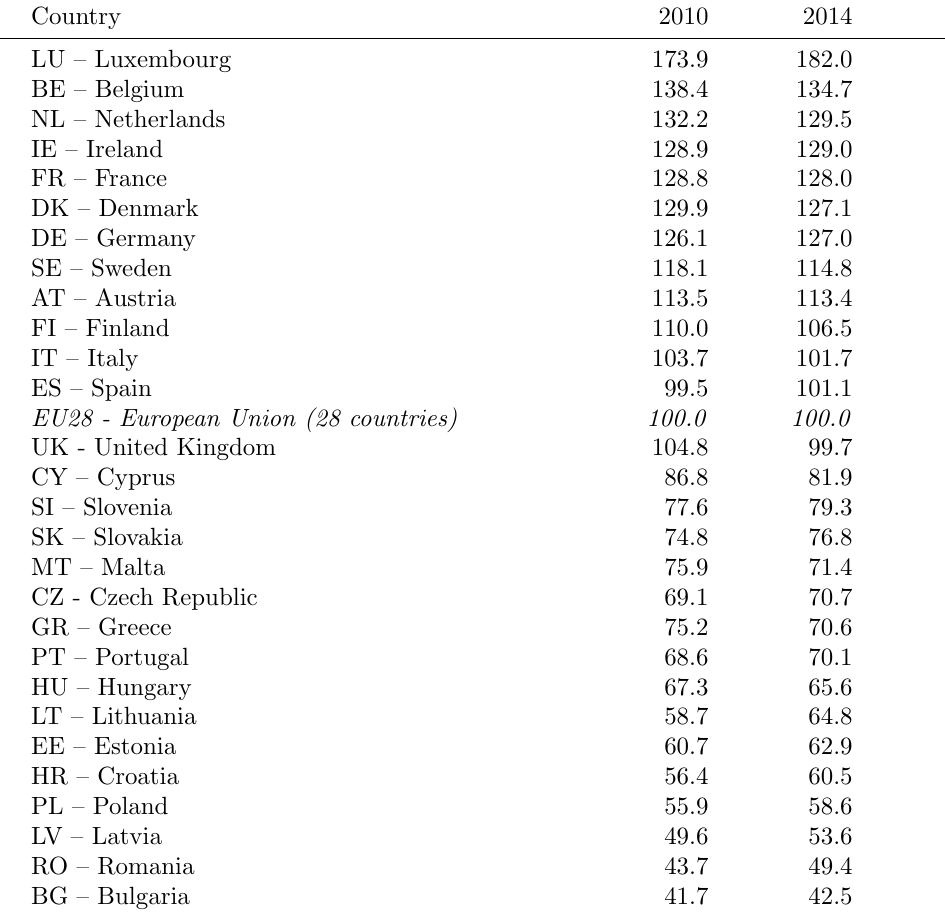
Table 1: Comparing productivity between European countries